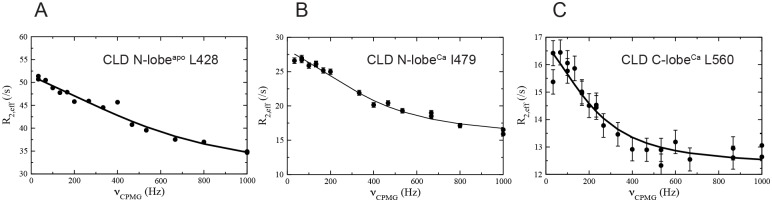
Examples of dispersion profiles for (A) CLD N-lobeapo, (B) CLD N-lobeCa and (C) CLD C-lobeCa.The lines represent the best fit to a local two-state process for CLD N-lobeapo and to a global two-state process for CLD N-lobeCa and CLD C-lobeCa. The data was recorded at a static magnetic field of 14.1 T at 25°C. The values of the fitted global exchange parameters are presented in the text. Dispersion profiles for all residues with μs–ms dynamics can be found in S2–S4 Figs.